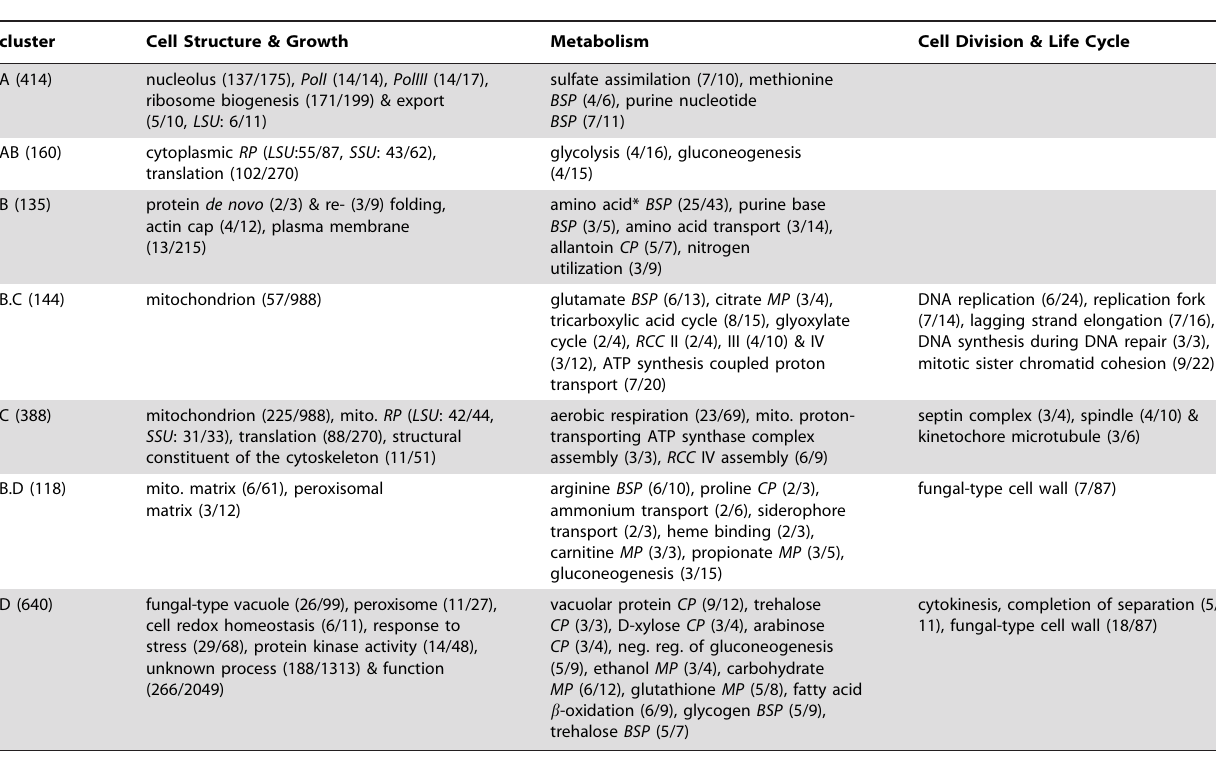
Table 1. Significantly enriched GO terms of consensus